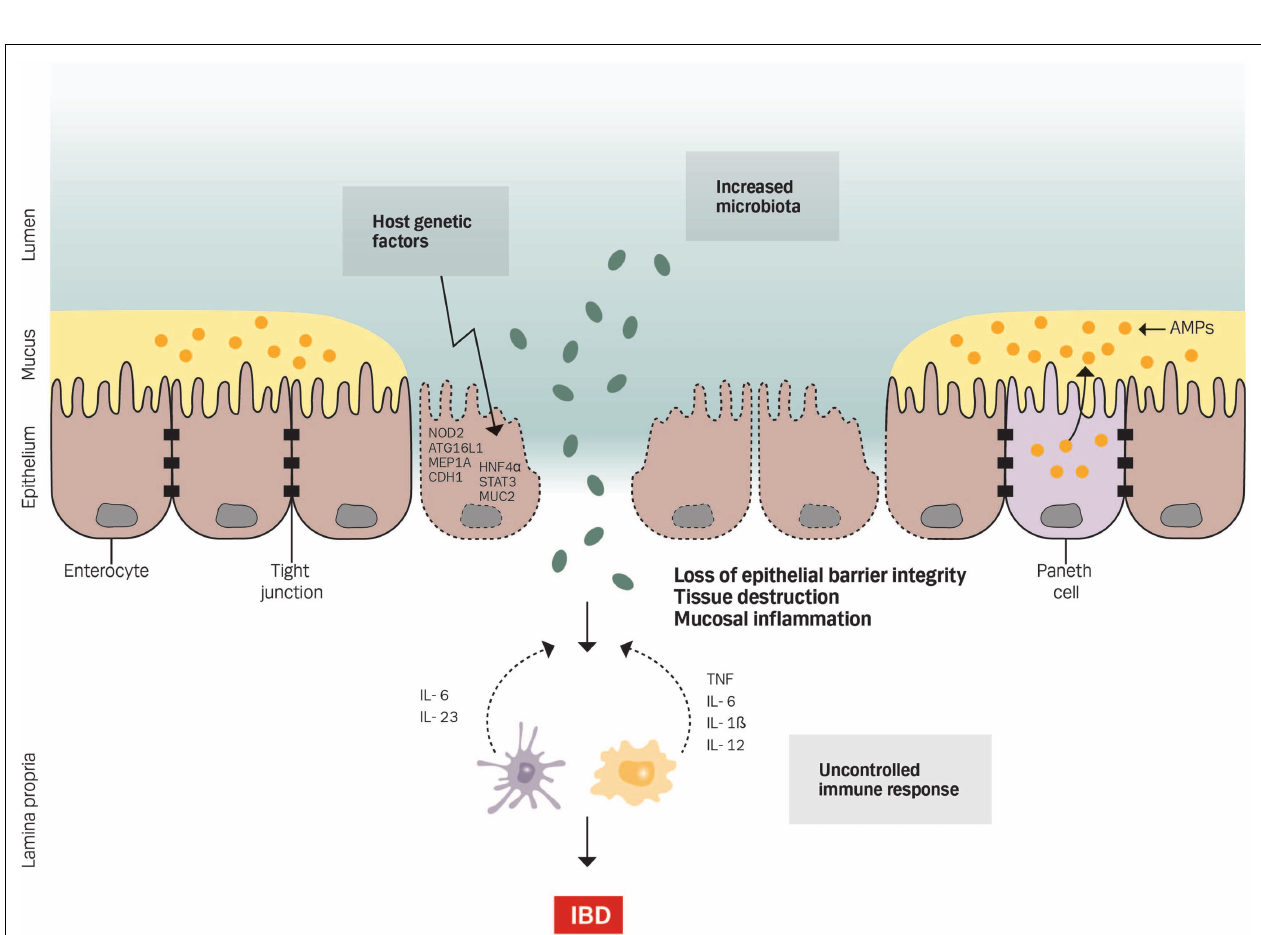
FIGURE 1 | Genetics, gut microbiota, and an uncontrolled immune response cause defects in epithelial barrier function by affecting the barrier integrity, increasing tissue destruction and mucosal inflammation .